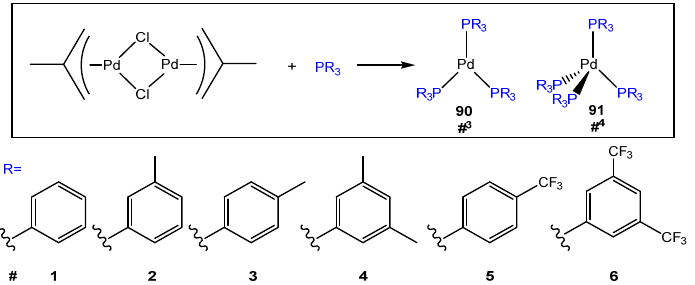
Figure 25. Syntheses and abbreviations of the unusual fl uorescent Pd(0) complexes 90 and 91 . Adapted from